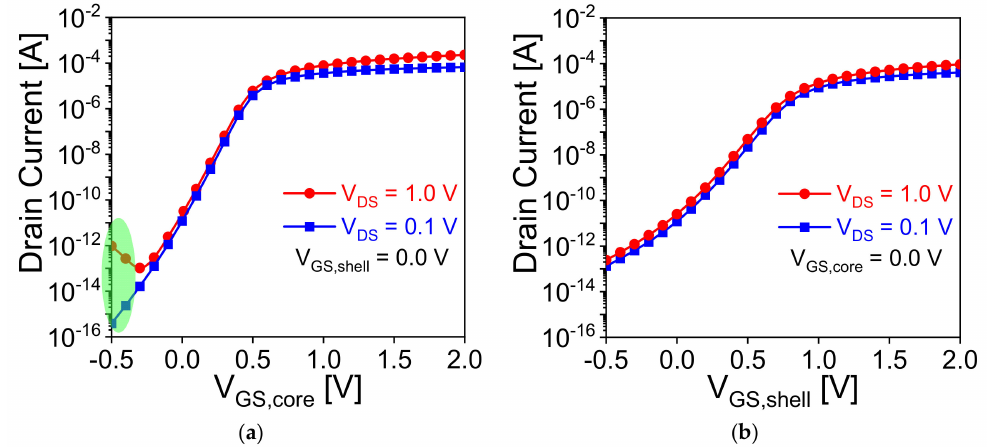
Figure 3. Dual-gate operations of the synaptic memory device. Transfer characteristics at V DS = 0.1 V and 1 V. ( a ) I D - V GS,core curves at V GS,shell = 0 V. ( b ) I D - V GS,shell curves at V GS,core = 0 V. L g = 100 nm and T Si = 20